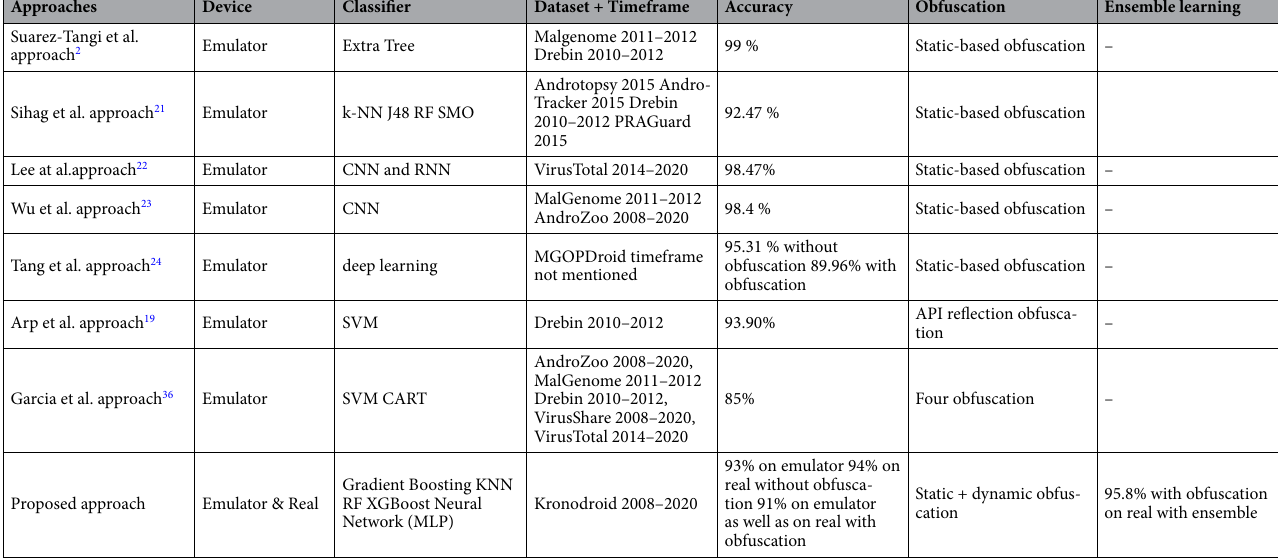
Table 7. Summarizing the proposed approach with the state-of-the-art approaches in terms of platform, classifier, dataset used along with their accuracy and obfuscation technique